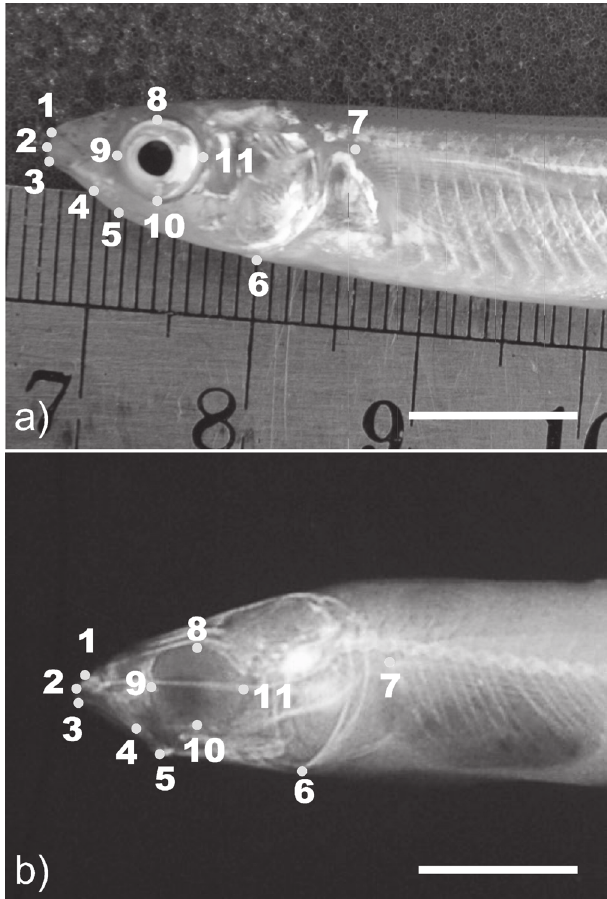
Fig. 3. Homologous landmarks on the left lateral view of the head of a just captured juvenile ( a ) and ( b ) X-ray image of skeletal structures: (1) anterior dorsal tip of premaxilla, (2) anterior ventral tip of premaxilla, (3) anterior tip of dentary, (4) posterior ventral tip of premaxilla, (5) posterior ventral tip of maxillary, (6) ventral contact point between symplectic and preoperculum, (7) upper tip of pelvic fin base, and (8, 9, 10, and 11) upper, lower, anterior and posterior edge of eye. Bar = 10 mm.